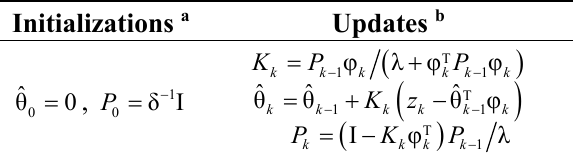
Table 1. Procedures of the recursive least-squares (RLS) for parameter identification. Initializations a Updates